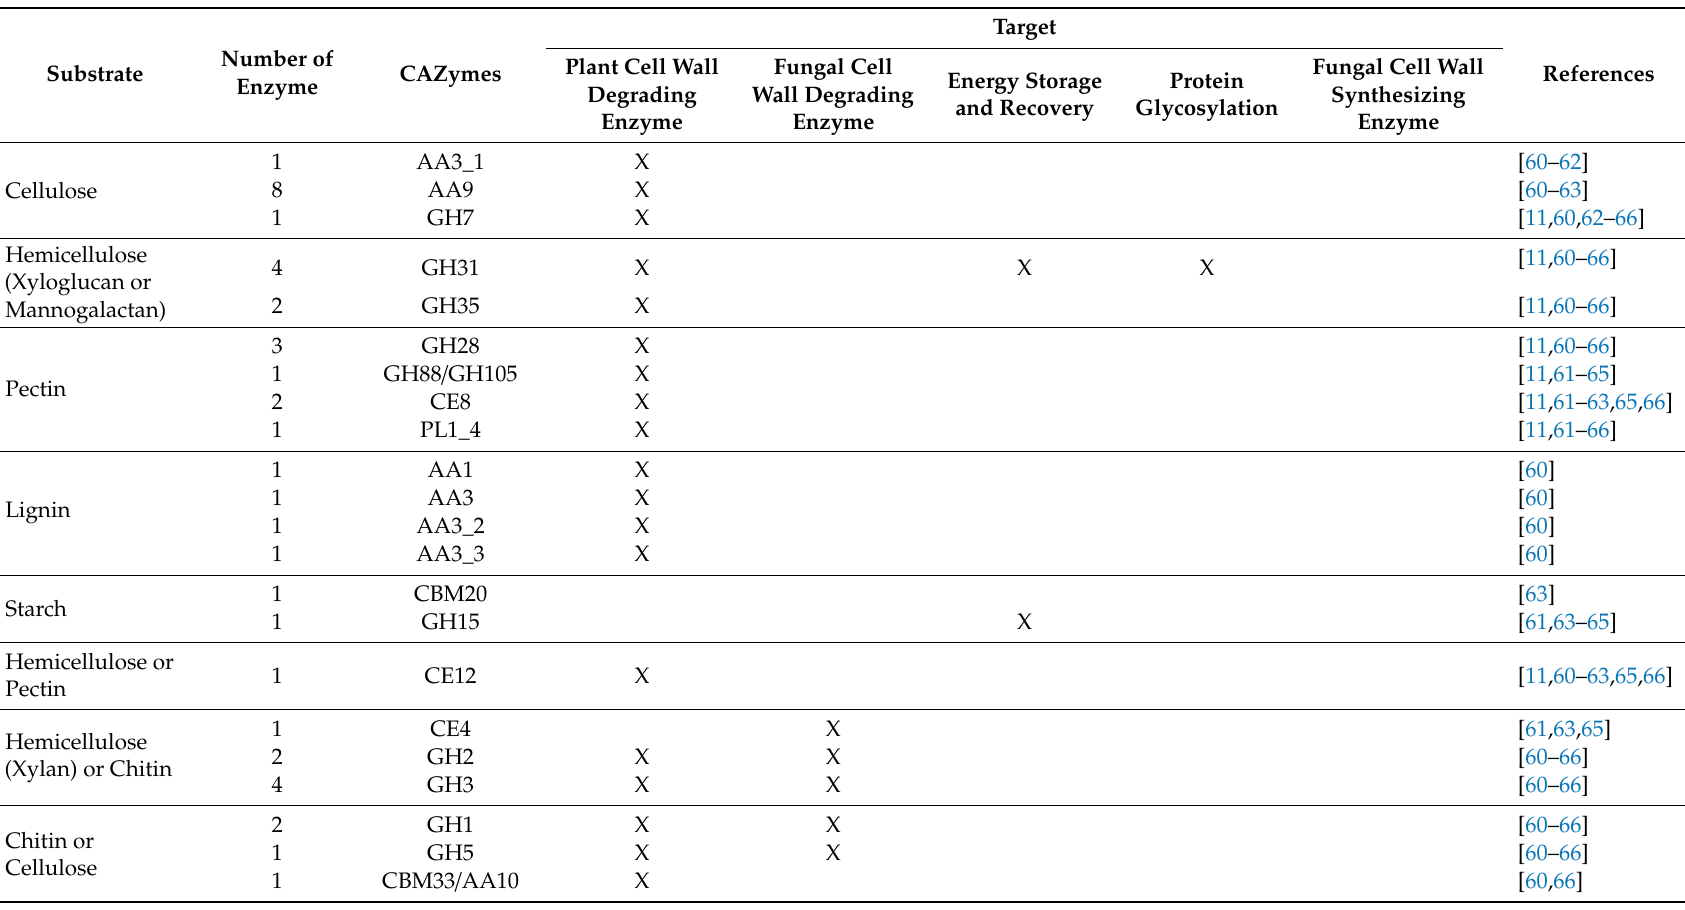
Table 3. Overview of the specific functions of CAZymes encoded by DEGs or identified in C. lupini during interaction with white